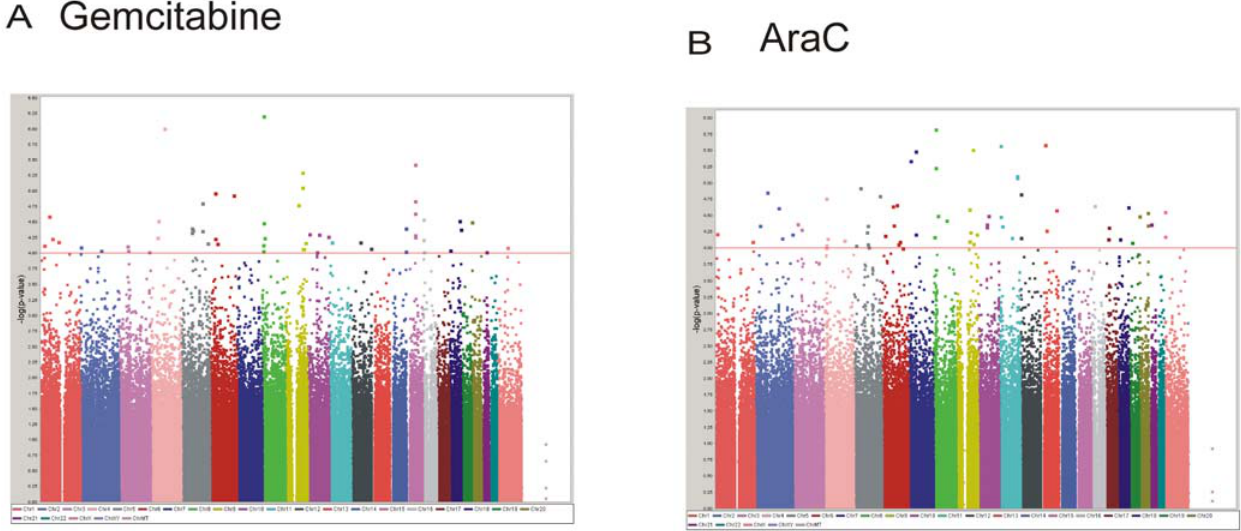
Figure 1. Genome-wide SNP association with drug IC 50 . (A). Genome-wide SNP-gemcitabine IC 50 association data. (B). Genome-wide SNP-AraC IC 50 association data. Genome-wide SNPs were obtained for all 171 cell lines using Illumina 550K Beadchips. Genome-wide SNP association analysis was then performed with gemcitabine IC 50 as the drug-response phenotype (n=171). The y-axis is the 2 log10 (p-value) for the SNP. SNPs are plotted on the x-axis on the basis of their chromosomal locations. The ‘‘cut-off’’ p-value of 0.001 is highlighted with a red line.